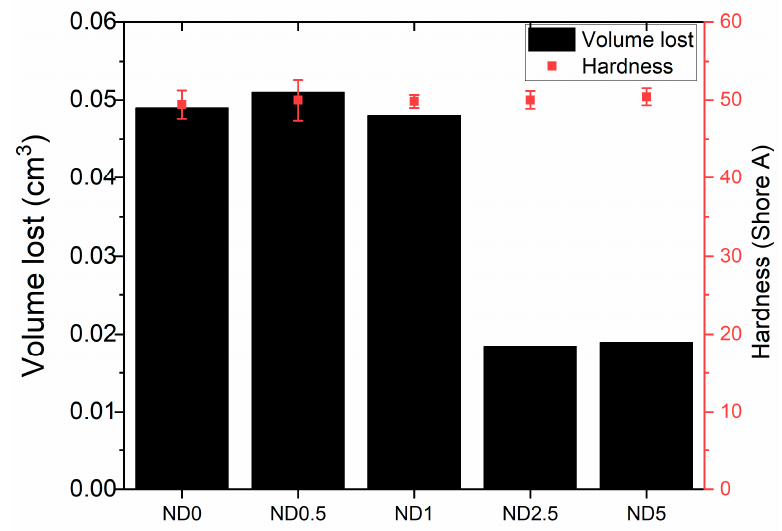
Figure 4. Wear resistance of ND-CB filled rubber compound.